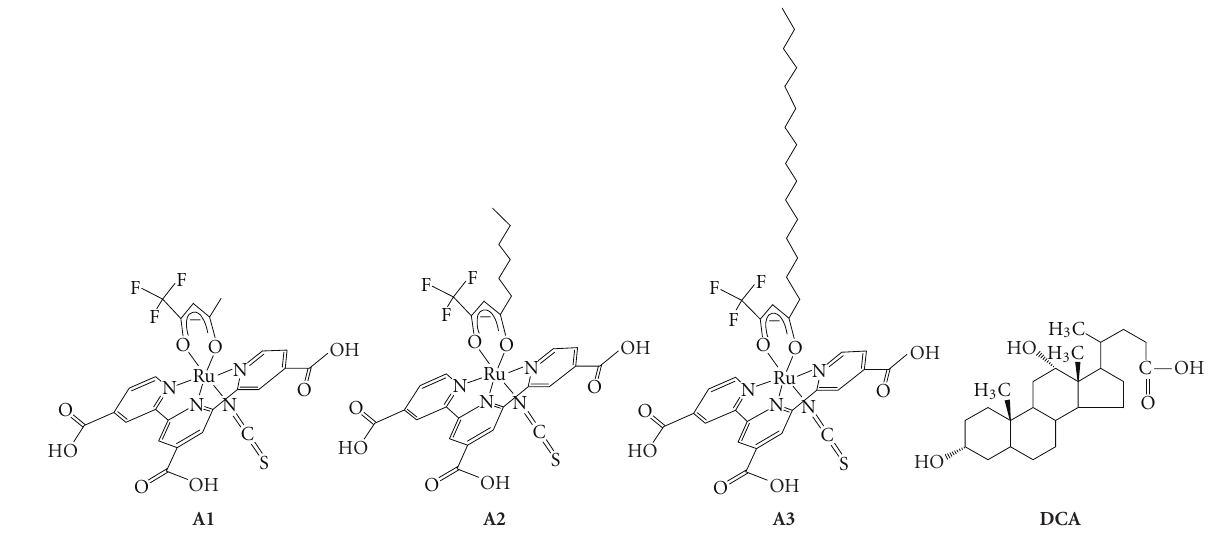
Figure 1: Molecular structures of complexes A1 , A2 , A3 , and DCA . Table 1: Absorption, luminescence, and electrochemical properties of the ruthenium